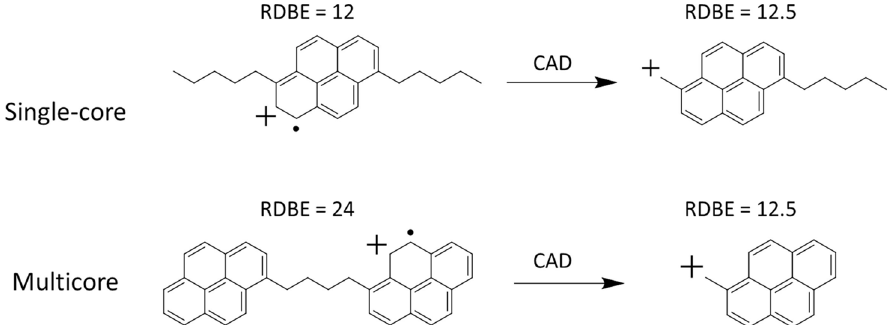
Figure 9. Fragmentation of a single core and multicore asphaltene molecular ions upon single stage CID [157]. The product ion generated upon CID of the single core precursor ion showed an increase in RDBE by 0.5, and the product ion generated upon CID of the multicore precursor ion showed a decrease in RDBE by 11.5. CAD, collision-activated dissociation, is the same technique as CID. Adjusted and reprinted with permission from Elsevier.